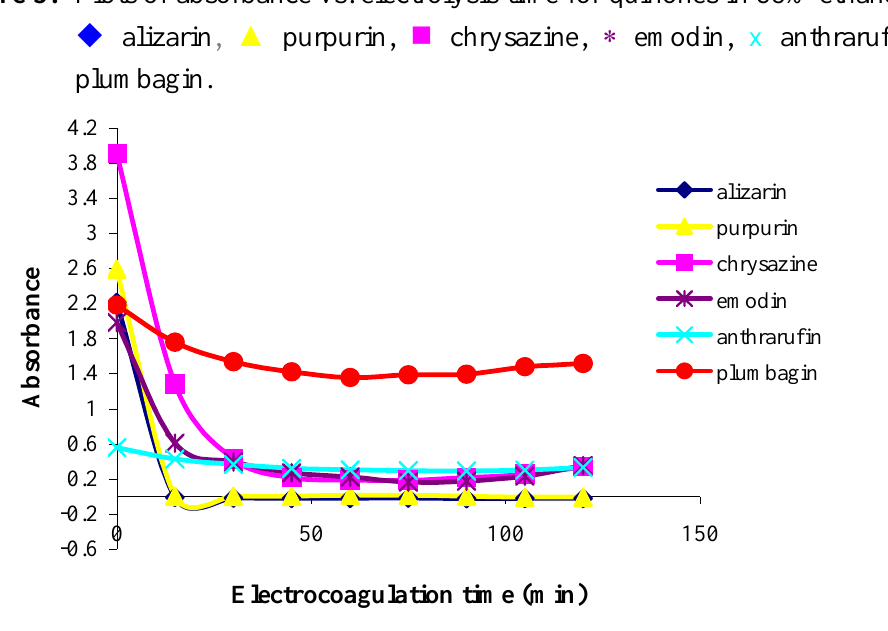
Figure 3. Plots of absorbance vs. electrolysis time for quinones in 85% ethanol solution; (cid:139) alizarin, ▲ purpurin, (cid:132) chrysazine, ∗ emodin, x anthrarufin, and (cid:122)